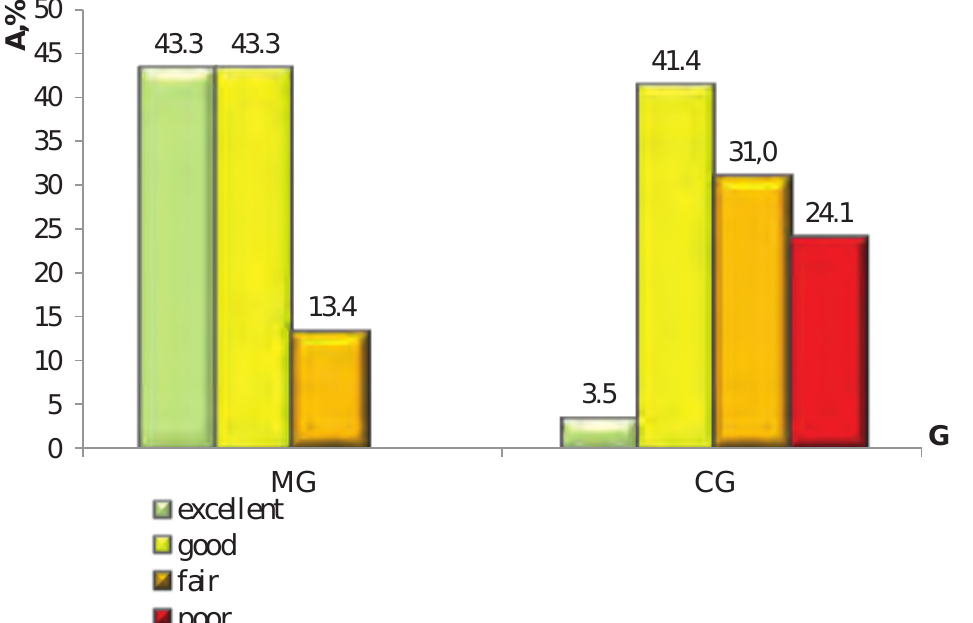
Fig. 1. Distribution of the total score of the scale for the evaluation of the results of patients’ treatment with Achilles tendon ruptures (according to Leppilahti at al. [17]) according to the gradation of the results: A - percentage of patients,%; G group; MG – main group; CG – control group; excellent – excellent result (excellent); good – good result (good); fair – satisfactory result (fair); poor – unsatisfactory result